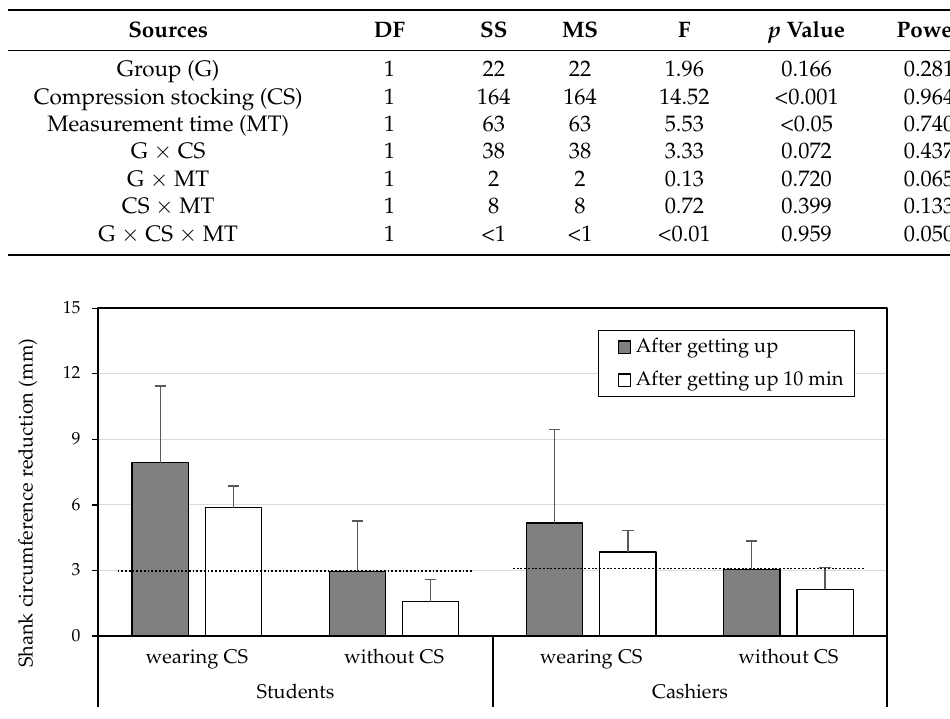
Figure 4. Effects of compression stockings (CSs) and measurement time on shank circumference reduction between groups. The dotted line indicates the baseline obtained after getting out of bed without CSs.